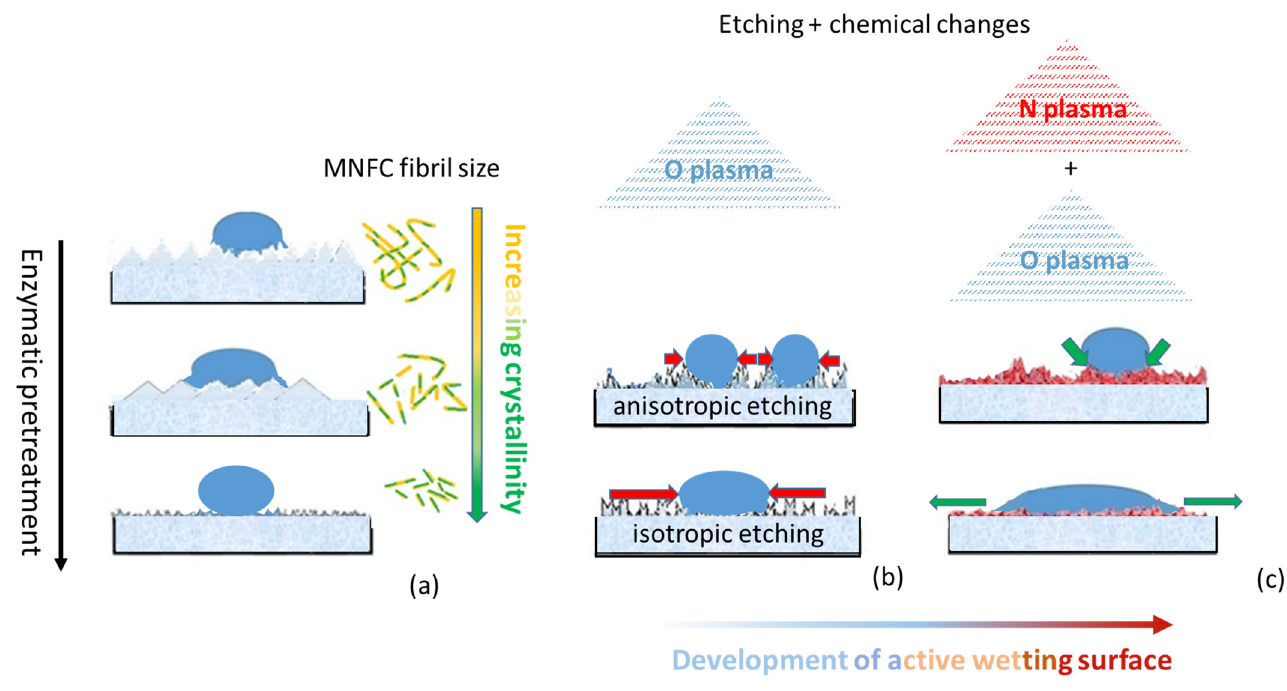
Figure 20. Schematic of how an isotropic mostly crystalline MNFC film can be formed by ( a ) producing the MNFC from enzymatically pretreated fibres, and that ( b ) by judicious exposure to a combination of gas plasma (exemplified by oxygen and nitrogen) ( c ) a desired wettability and surface energy distribution can be generated to provide a new generation of surface active cellulosic materials.